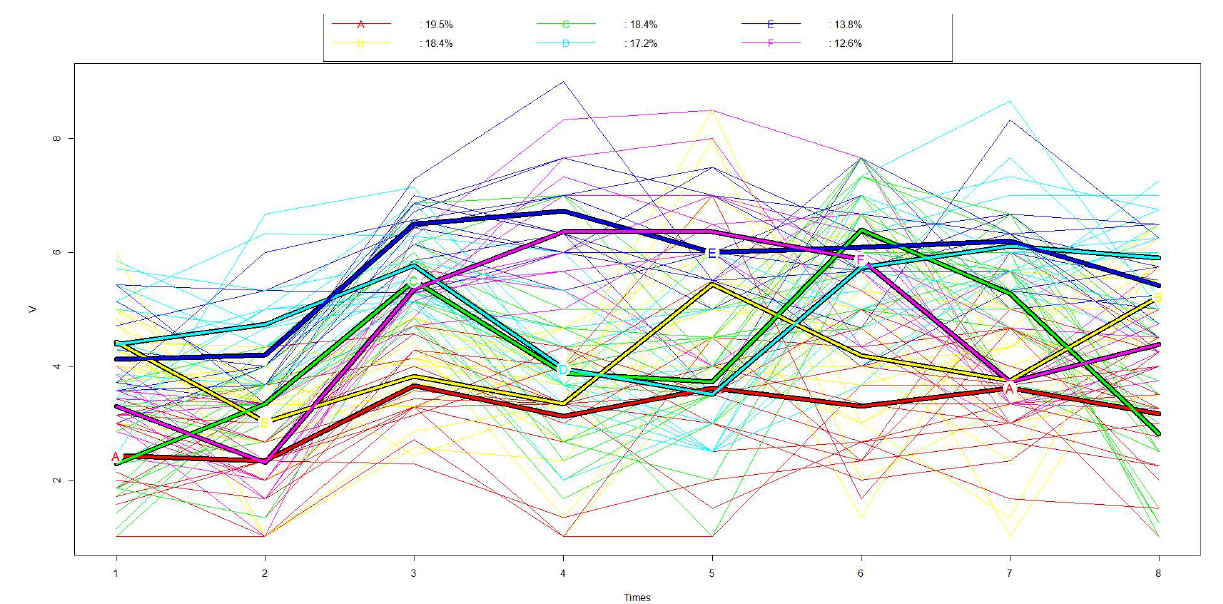
Figure 3. Based on the k-means clustering, six distinct clusters (A to F) were detected displaying different trajectories across the eight orientations. Table 3. The six clusters were obtained by k-means clustering using the kml